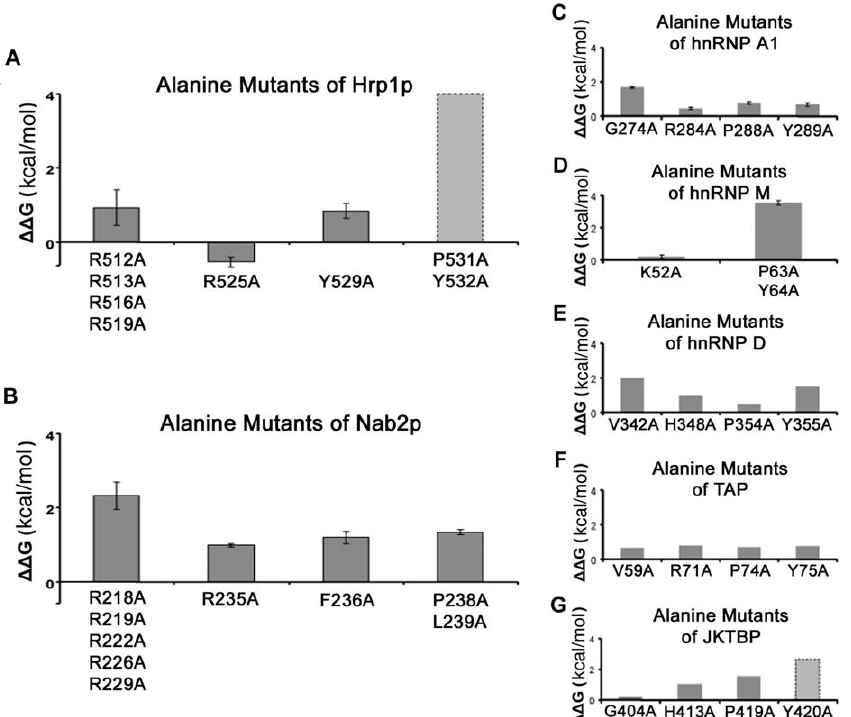
Figure 4. Mutagenic Analyses of the Hrp1p NLS, Nab2p NLS, and Human PY-NLSs (A and B) Loss of Kap104p binding energy in alanine mutants of (A) Hrp1p and (B) Nab2p ( DD G ¼ – RT ln( K D,wild type / K D,mutant ). (C–G) Loss of Kap b 2 binding energy in alanine mutants of PY-NLSs from (C) hnRNP A1, (D) hnRNP M, (E) hnRNP D, (F) TAP, and (G) JKTBP ( DD G ¼ – RT ln( K D,wild type / K D,mutant ). K D,wild type and K D,mutant values for hnRNP A1 were obtained from [16], hnRNP M from [26], hnRNP D, TAP, and JKTBP from [27]. K D values for Hrp1p, Nab2p, and hnRNPs A1 and M were obtained by ITC whereas those for hnRNP D, TAP, and JKTBP were obtained by surface